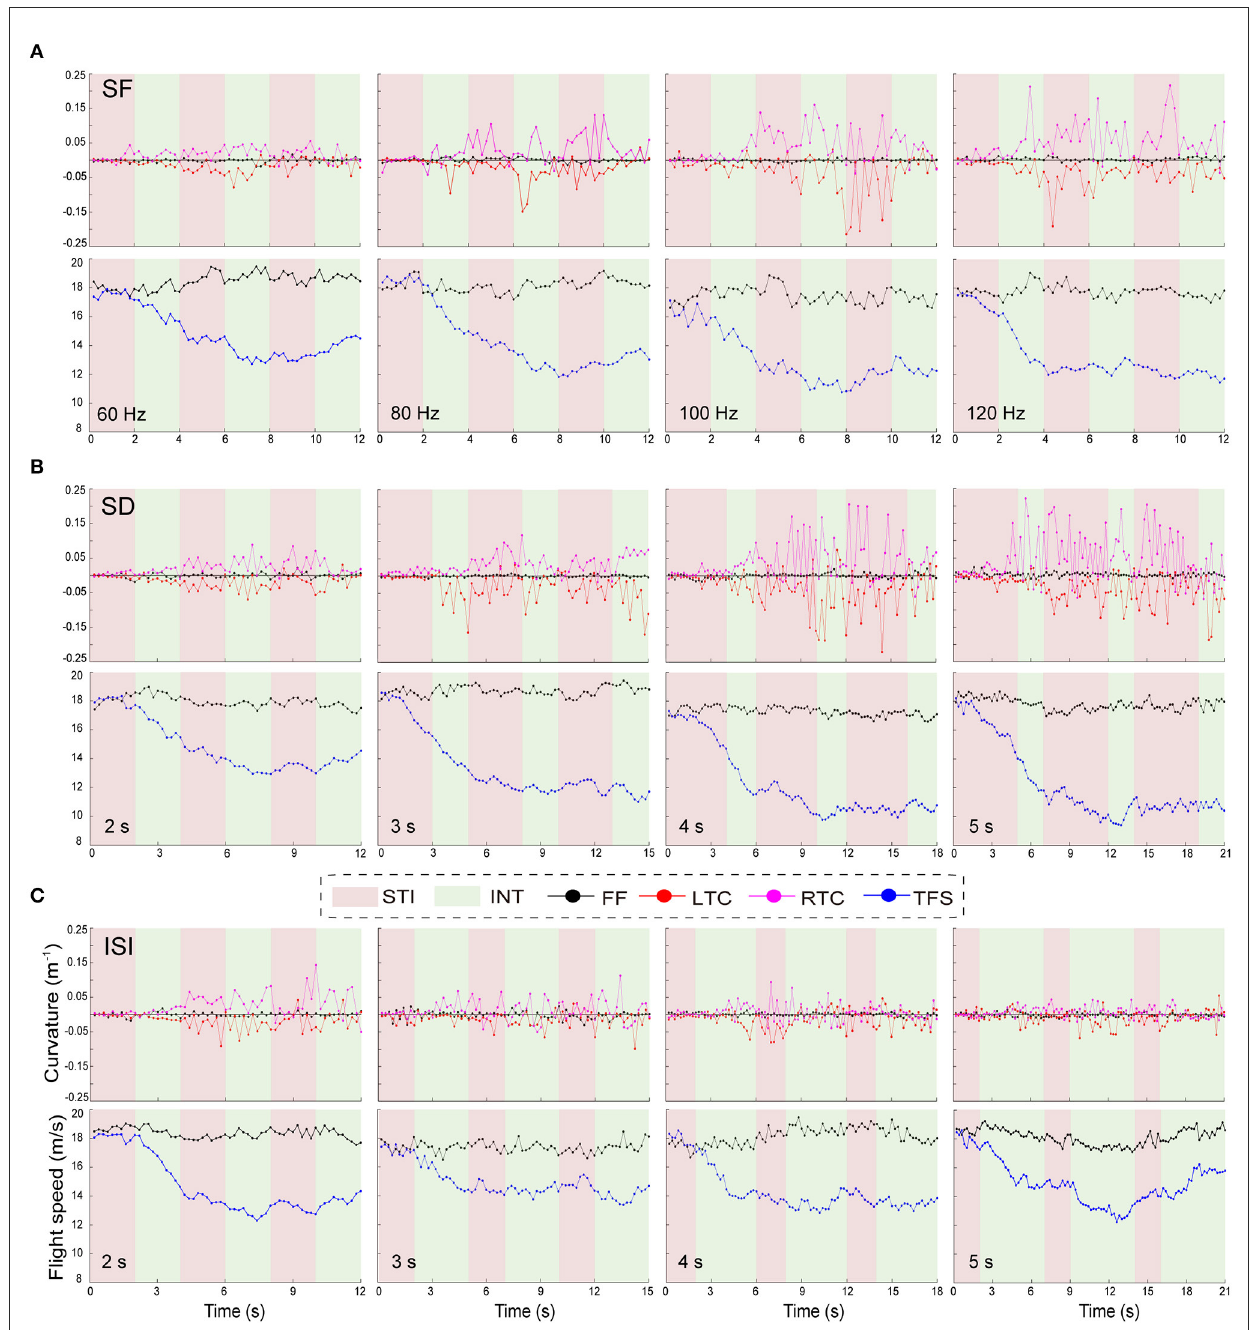
FIGURE7 Characteristics of the turning flight behavior of the robo-pigeon during the complete stimulation cycle. (A–C) indicate the variation of turning flight curvature and turning flight speed of the robo-pigeon within different parameters of SF, SD and ISI, respectively. SF, the stimulus frequency; SD, the stimulus duration; ISI, the inter-stimulus interval; STI, denote the stimulation (red regions); INT, denote the stimulation interval (green regions); FF, the flight speed and curvature of the robo-pigeon in free flight; LTC; the curvature of left-turning; RTC; the curvature of right-turning; TFS, the speed of turning